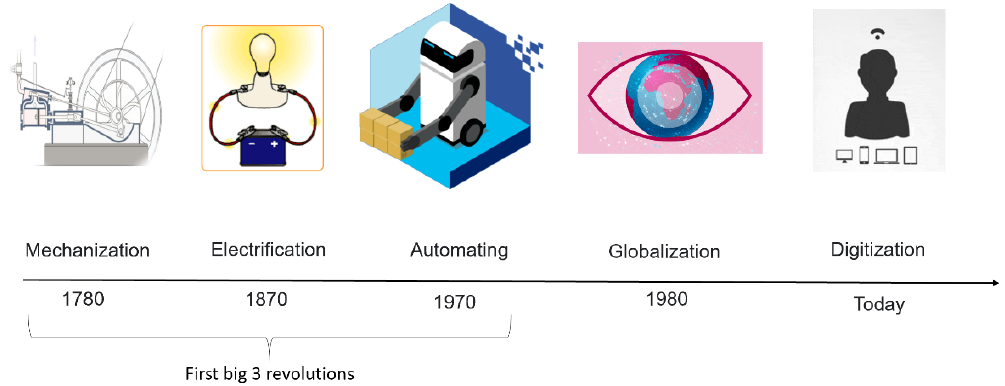
Figure 1. The different ages of industrial revolutions.